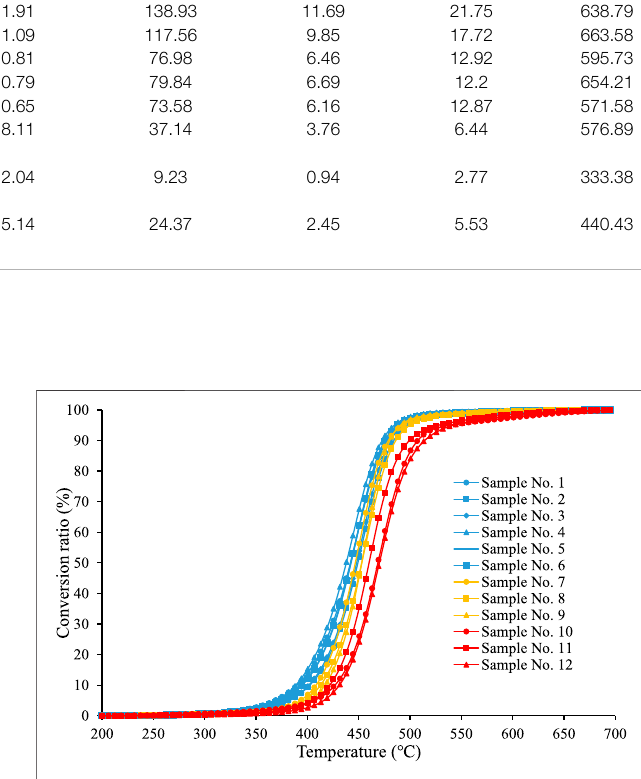
FIGURE 2 | Hydrocarbon generation conversion curves of the open system